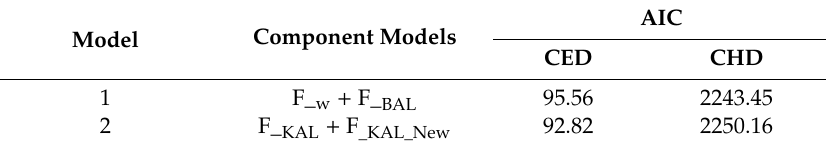
Table 3. Structure and fitting of the applied models.